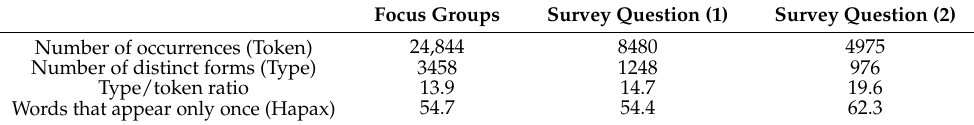
Table 2. Lexicometric measures of the corpora underwent automatic text analyses. Focus Groups Survey Question (1) Survey Question (2) Number of occurrences